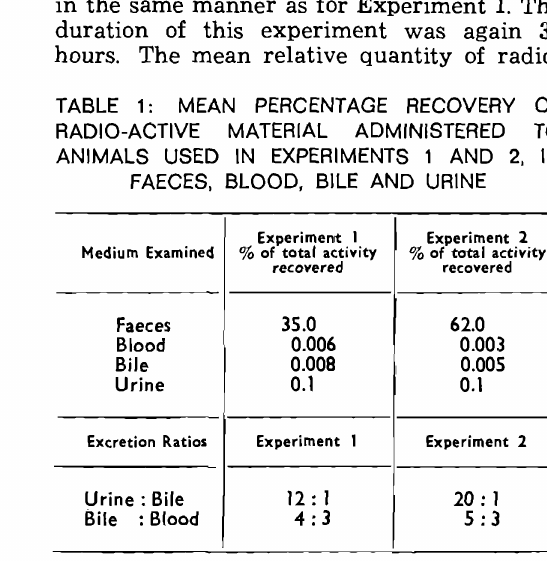
MEAN PERCENTAGE RECOVERY OF RADIO-ACTIVE MATERIAL ADMINISTERED TO ANIMALS USED IN EXPERIMENTS 1 AND 2, IN FAECES, BLOOD, BILE AND